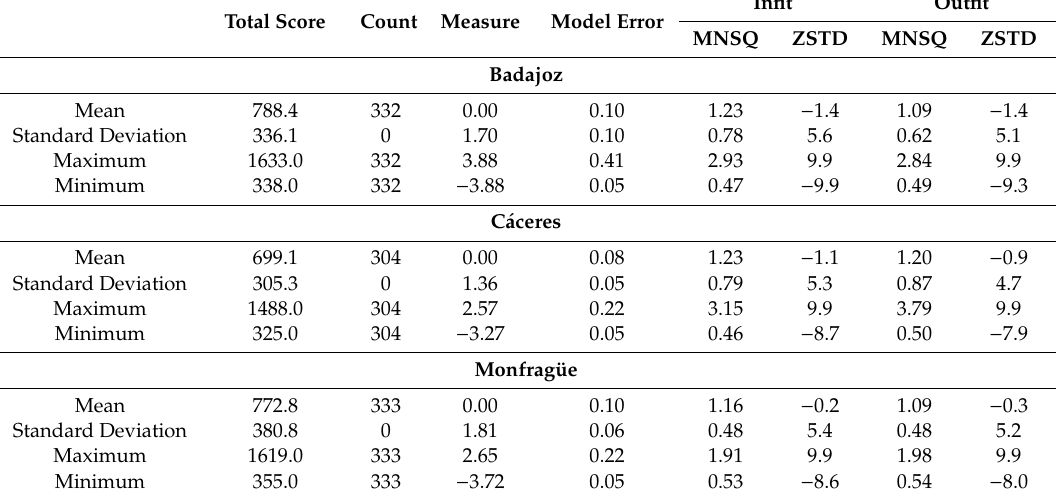
Table 1. Overall model fit information; summary of all 13 individual pollutants and climatic variables (items) for the three locations: sum of points of the common scale (total score), days or items taken into account (count), logit position of the days and items along the straight line that represents the latent variable, atmospheric pollution (measure), and standard error of measurement (model error). Infit and outfit MNSQ are mean-square fit statistics to verify if items fit the model; infit and outfit ZSTD are standardized fit statistics to verify if items fit the model.